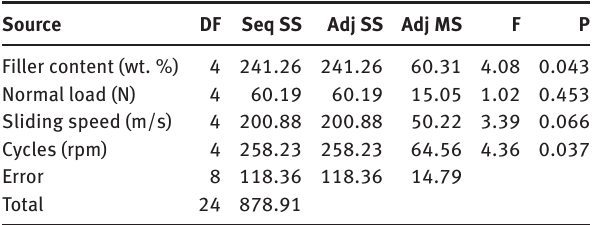
Table 8: ANOVA table for specific wear volume of marble dust-filled dental